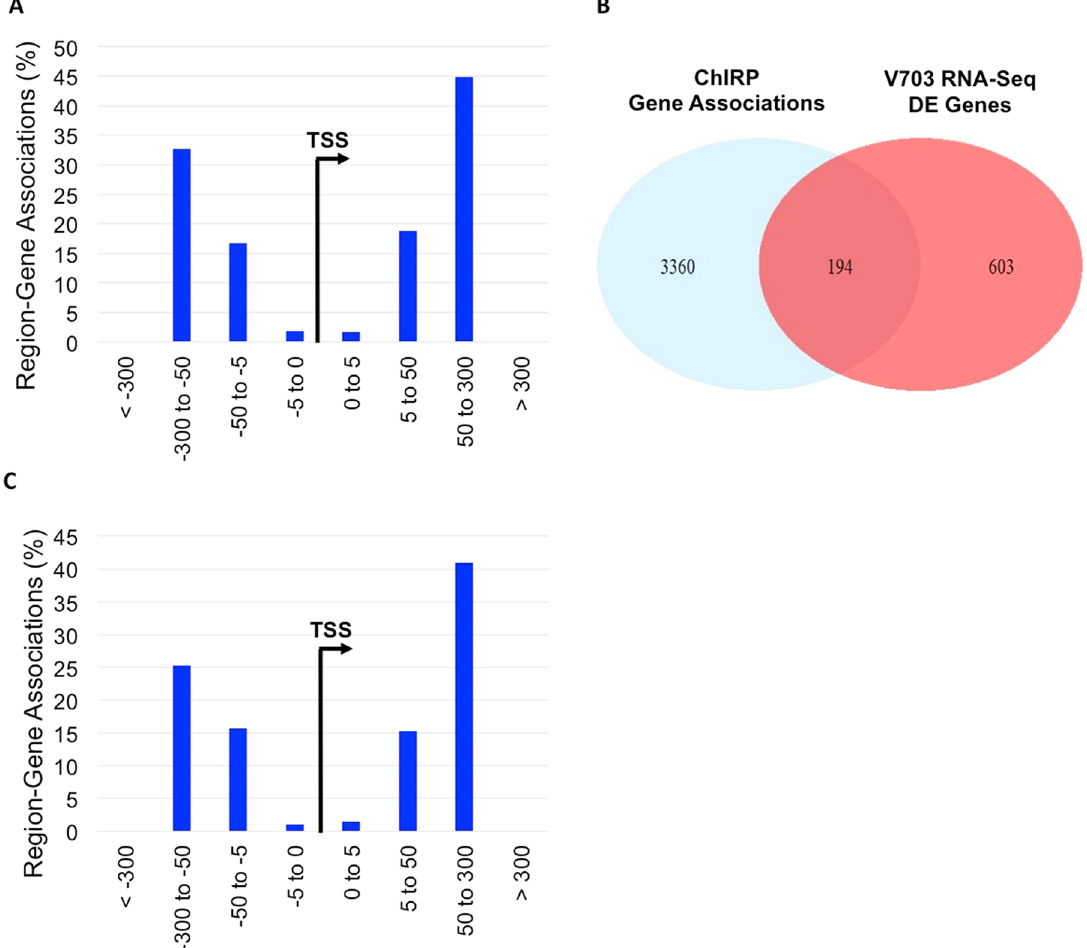
Figure 5. lincDUSP associates with chromatin within regulatory regions of differentially expressed genes. ( A ) The genome-wide occupancy of lincDUSP was identified by ChIRP-seq. The distribution of distances of lincDUSP ChIRP-Seq peaks to transcription start sites of protein-coding genes is shown. ( B ) Overlap between genes that are within 300 kb of a lincDUSP ChIRP-seq peak and differentially expressed genes identified in V703 cells post lincDUSP KD (RNA-Seq). ( C ) The distribution of distances of lincDUSP ChIRP-Seq peaks to transcription start sites of protein-coding genes that are also differentially expressed upon KD of